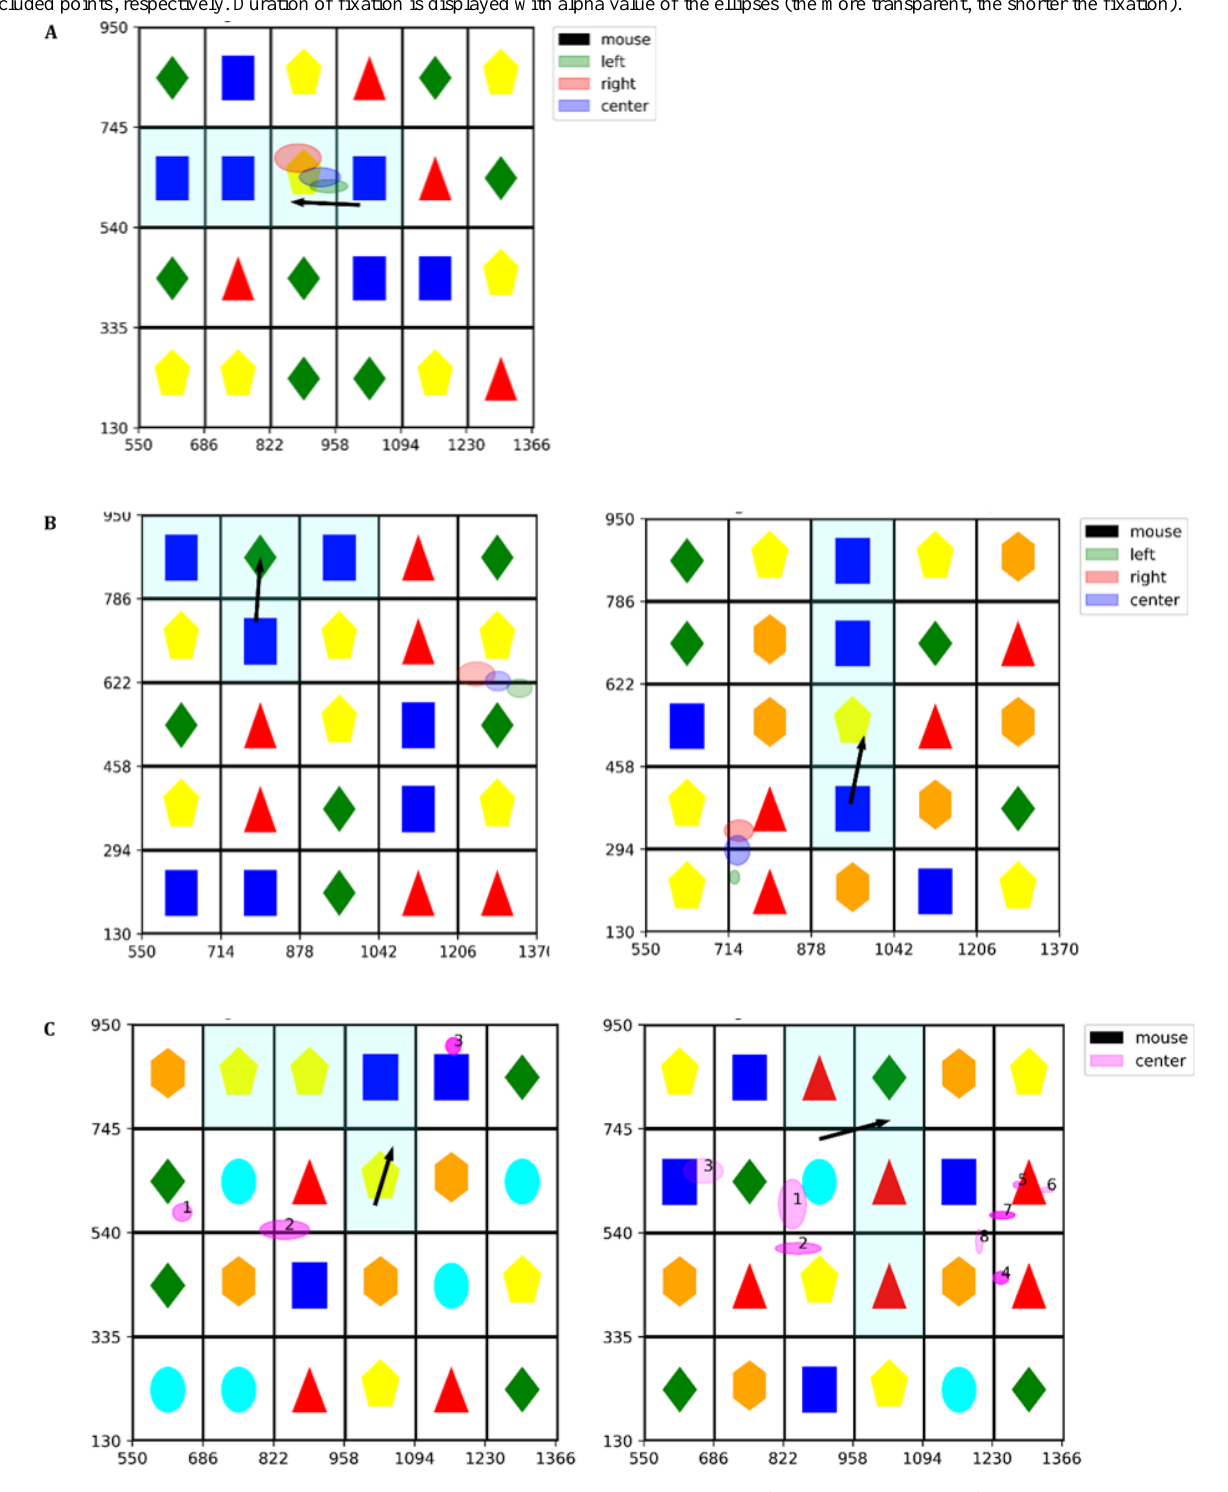
participants (ID 2, 5, 12, and 13) were excluded due to the limited number of recorded fixations. The reason for this unusable data for our purpose might be some measurement errors or bad calibration of the eye-tracking